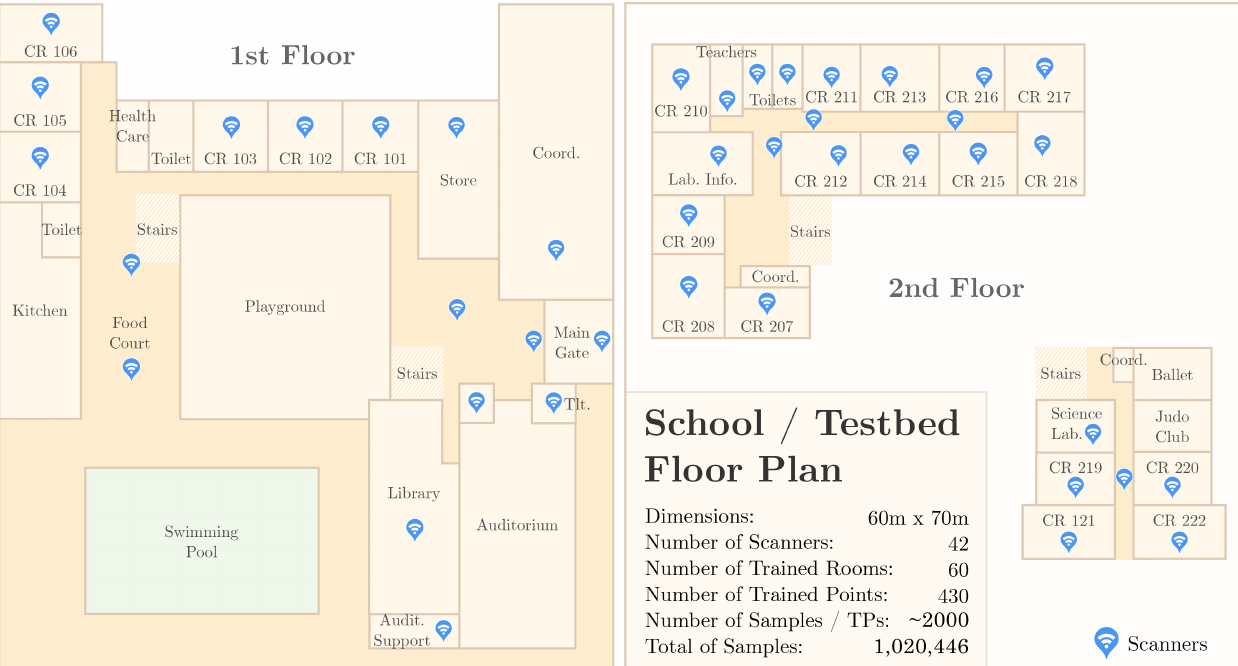
Figure 7. SmartCampus Testbed Floor Plan: an entire school composed of 60 rooms/halls were trained. Forty-two scanners were distributed throughout the school; 488 points were trained, about 2 m distant from each other; for each training point, about 2000 samples were collected, to a total of 1,020,446